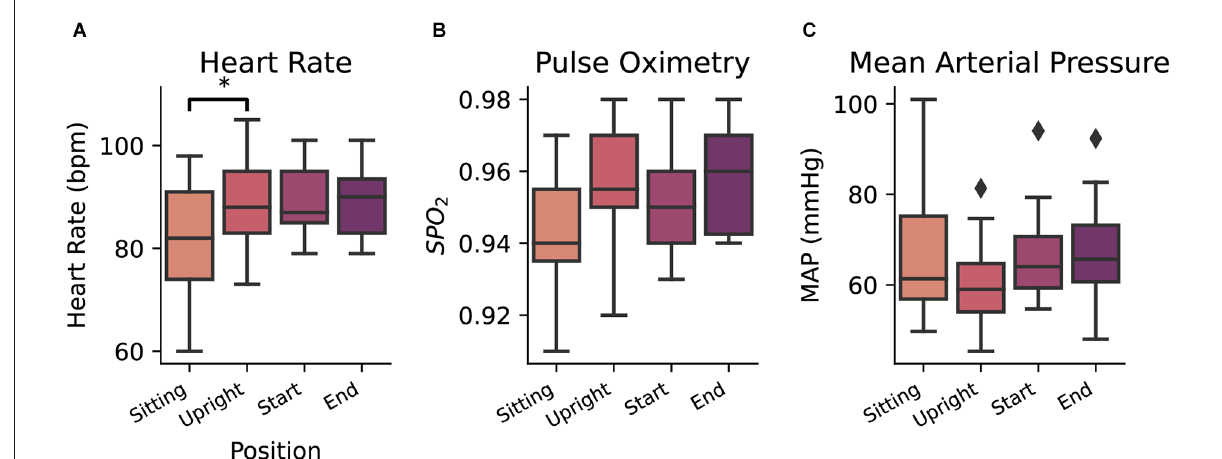
FIGURE2 Heart rate (A) , pulse oximetry (B) , and mean arterial pressure (C) measurements taken at four consecutive points (sitting in a wheelchair, upright position in the ambulation harness, at the beginning of the daily session, and at the end of the daily session). Diamond markers indicate data points that lie outside of 1.5 × IQR (Inter quartile range). ∗ p = <